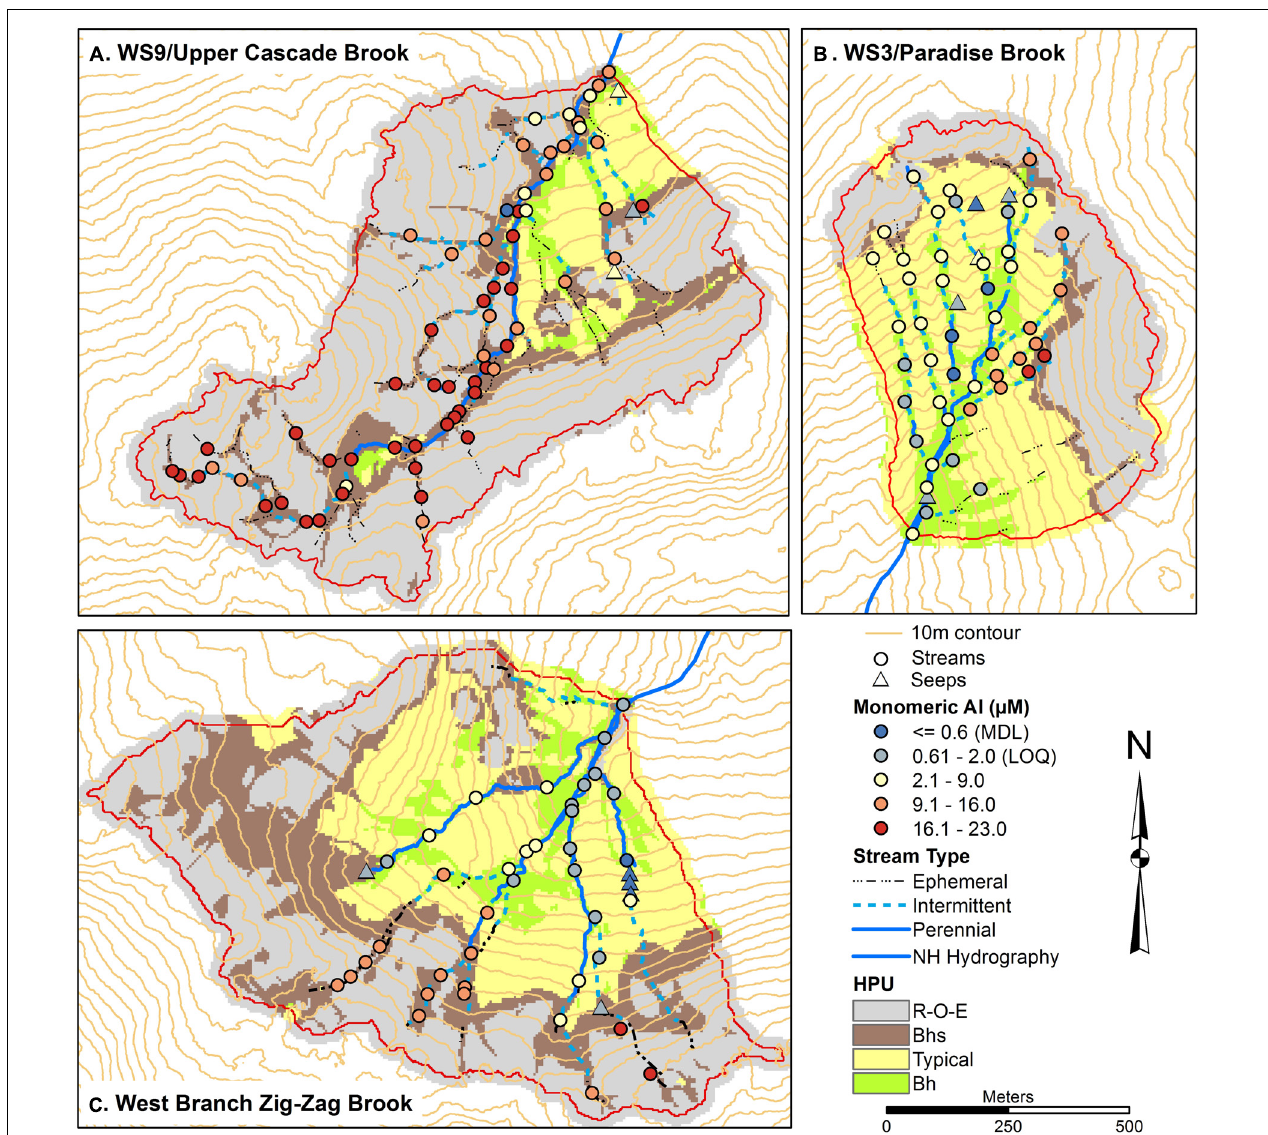
FIGURE 4 | Soils maps for W9 (A) , W3 (B) , and West Branch Zig Zag Brook (C) with variation in surface water total monomeric aluminum (Al m ) concentrations from a synoptic survey conducted July 22–23, 2015. Surface water samples were classified as streams (circles) or seeps (triangles). Soil units include bedrock